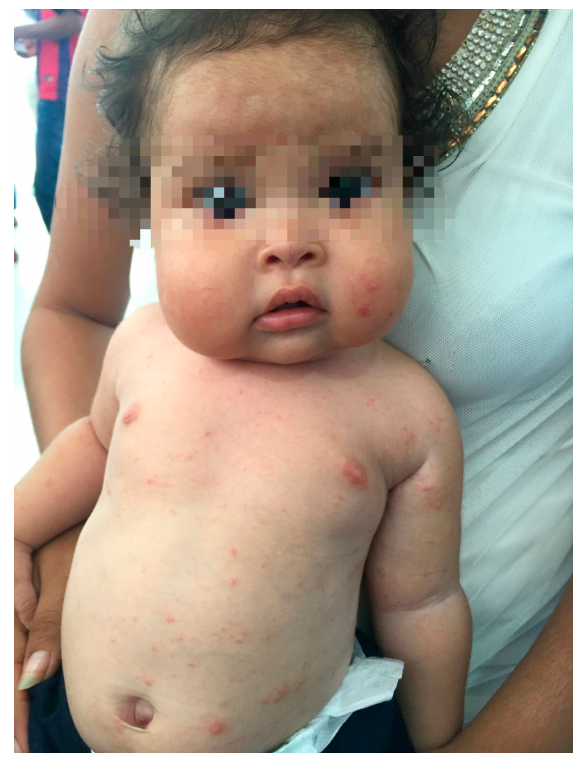
Figure A2. Prominent cheeks, mild telagiectasias and disseminated papulo-nodular lesions.